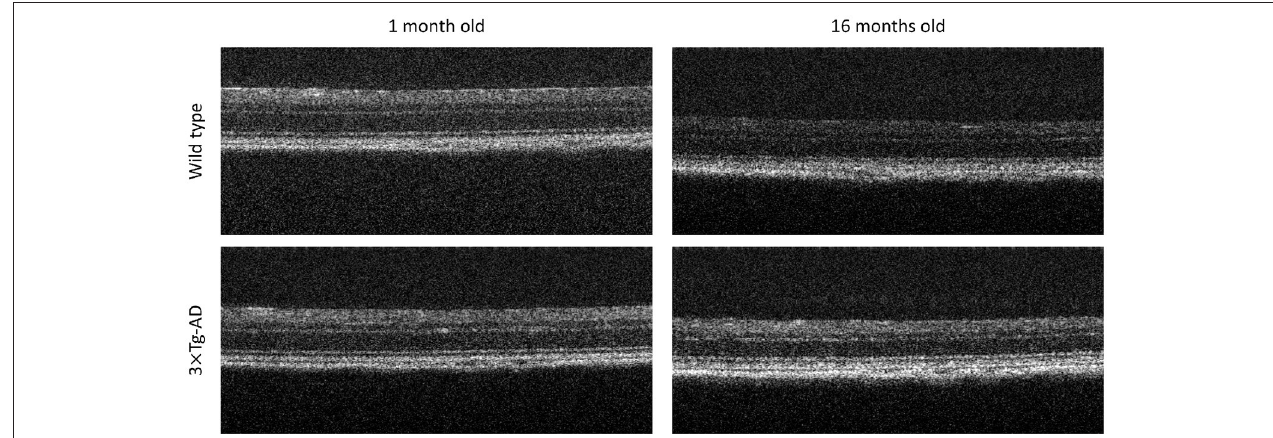
FIGURE 1 | Representative optical coherence tomography B-scans. Top to bottom , B-scans of a Wild type and a triple transgenic familiar Alzheimer’s disease mouse model (3 × Tg-AD), imaged at 1 and 16 months old, right to left , respectively.